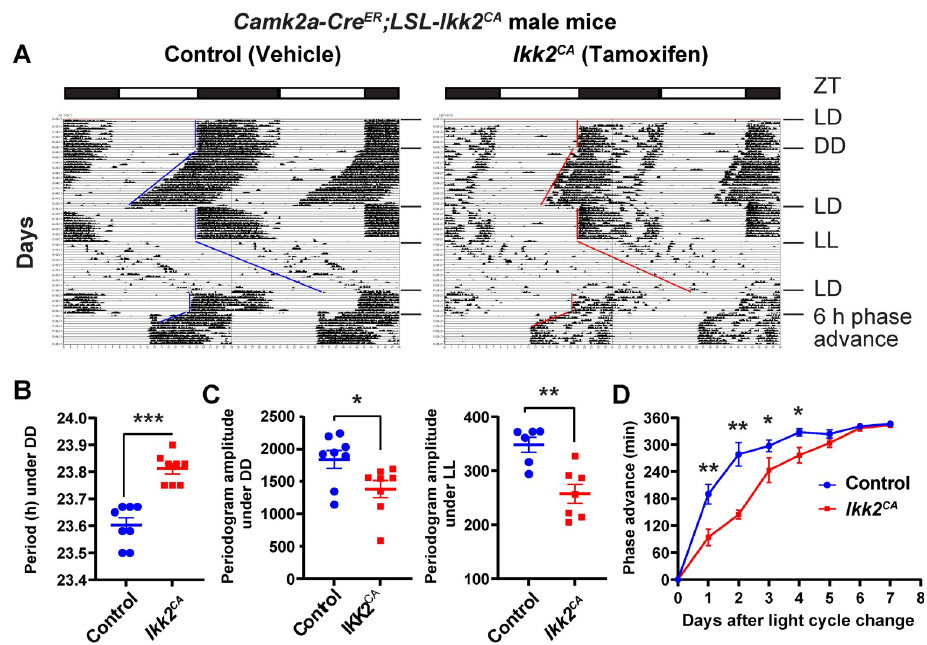
Fig 3. NF- κ B affects circadian locomotor activity behavior. (A) Representative double-plotted actograms of wheel- running activity in vehicle control (corn oil) and Ikk2 CA male mice. X axis: zeitgeber time (ZT) of the 12 h/12 h light/ dark cycle (LD) indicated by the bar (top). Y axis: number of days during the experiment. Mice were first entrained to a regular LD cycle and then released to constant darkness (DD) or constant light (LL). For phase shifting, mice were first entrained to LD and then the LD cycle was advanced for 6 h. (B) Circadian free-running period length in DD. (C) Periodogram amplitude of wheel-running behavior in mice under DD (left) and LL (right). (D) Line graphs showing the daily phase advance of wheel-running activity following a 6 h advancing LD cycle shift. Values are mean ± standard error (SE) (n = 7–8 mice for each group). � p < 0.05. �� p < 0.01. ��� p < 0.001 Ikk2 CA mice vs. vehicle by ANOVA.